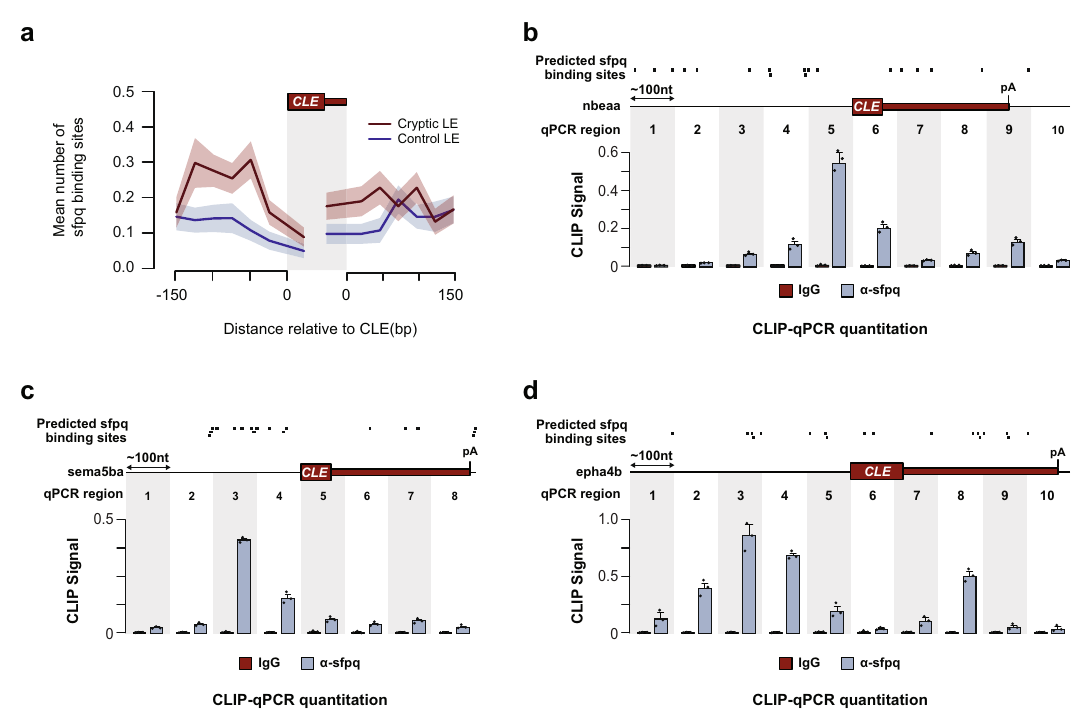
Fig. 4 SFPQ directly binds to CLE-adjacent RNA sequences. a Metaplot showing the distribution of predicted SFPQ-binding sites surrounding CLEs (red) and constitutive last exons of each CLE-containing gene (blue). In total, 200 bp of surrounding intron/CLE junction sequence (150 bp intron and 50 bp exon) were binned into 50 bp windows and the mean number of predicted motifs is shown ±SEM. b – d Top: location of SFPQ-binding motifs predicted using the MEME suite. Bottom: RT-qPCR quantitation showing the relative enrichment of SFPQ-interacting regions surrounding CLEs. RT-qPCR primer pairs were designed for each 100-bp sequence window demarcated by alternating gray and white areas. Abundance of SFPQ- or IgG(control)-crosslinked RNAs were normalized to input and the mean value from three replicates were shown ±SD. Source data are provided as a Source Data fi